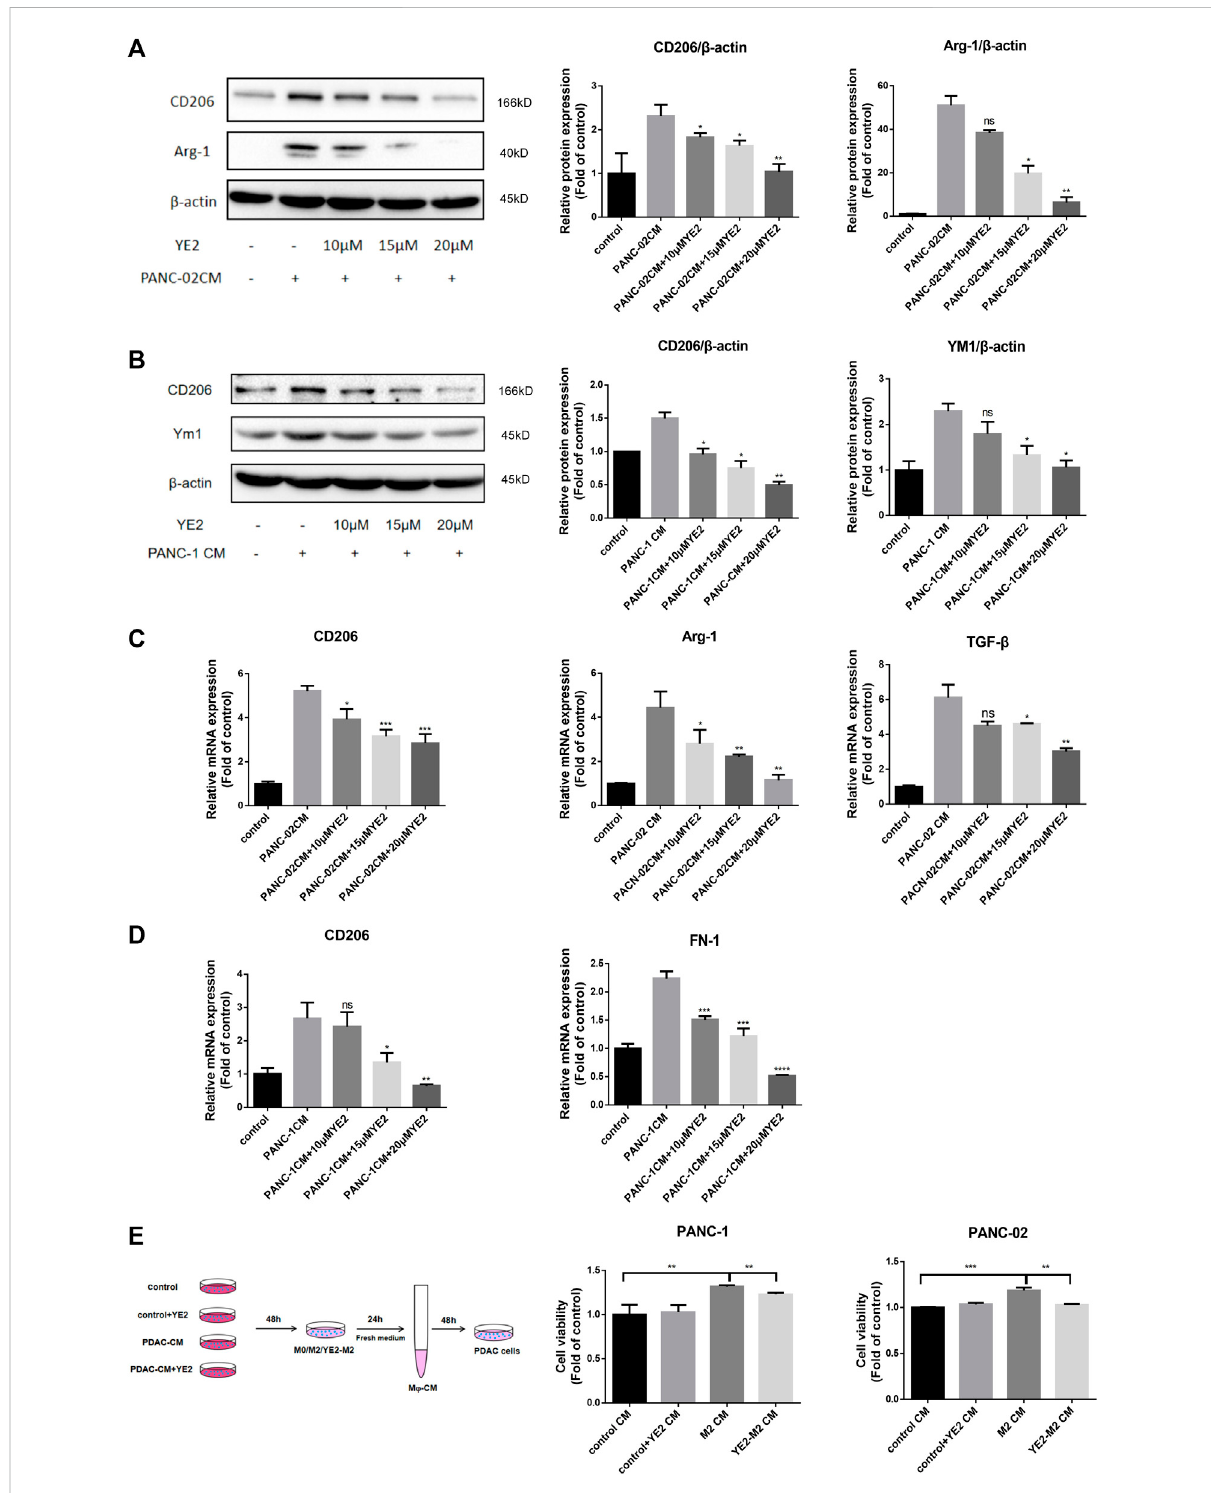
FIGURE 4 SMS2 inhibitor attenuates M2 polarization induced by CM of pancreatic cancer cells cultured in vitro . The conditioned medium of PANC-02 and PANC-1 was used to culture BMDM (A) and THP-1 (B) with or without YE2, respectively, and the cells were analyzed by immunoblotting after 48 h. The M2 polarization of BMDM (C) and THP-1 (D) was detected by Realtime PCR after 24 h. (E) . Conditioned medium of THP-1 and BMDM incubated in PDAC-CM with or without YE2 was collected to culture PANC-1 and PANC-02 cells. Data is presented as the mean ± SD of three representative experiments. * p < 0.05; ** p < 0.01; *** p < 0.001; **** p <